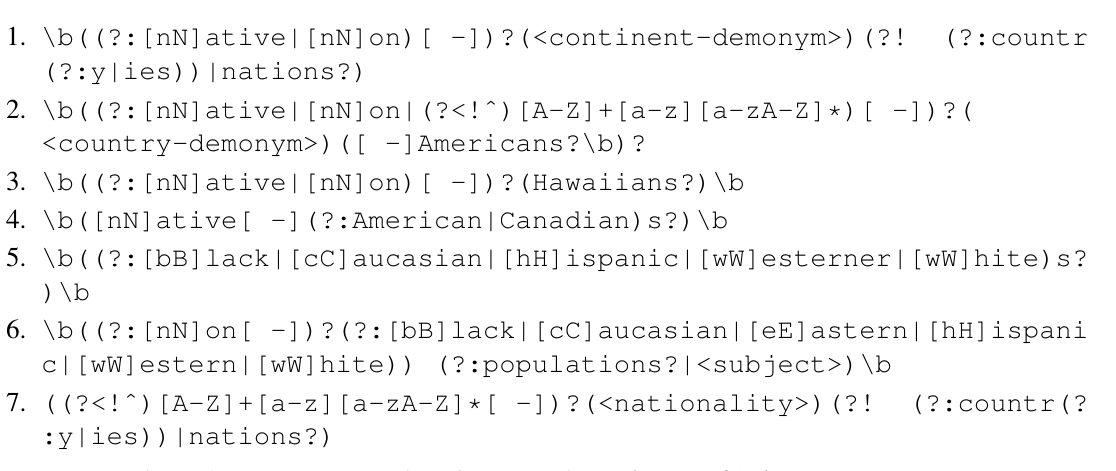
Figure 2: Regular expressions for extracting Ethnicity of Subjects parameter